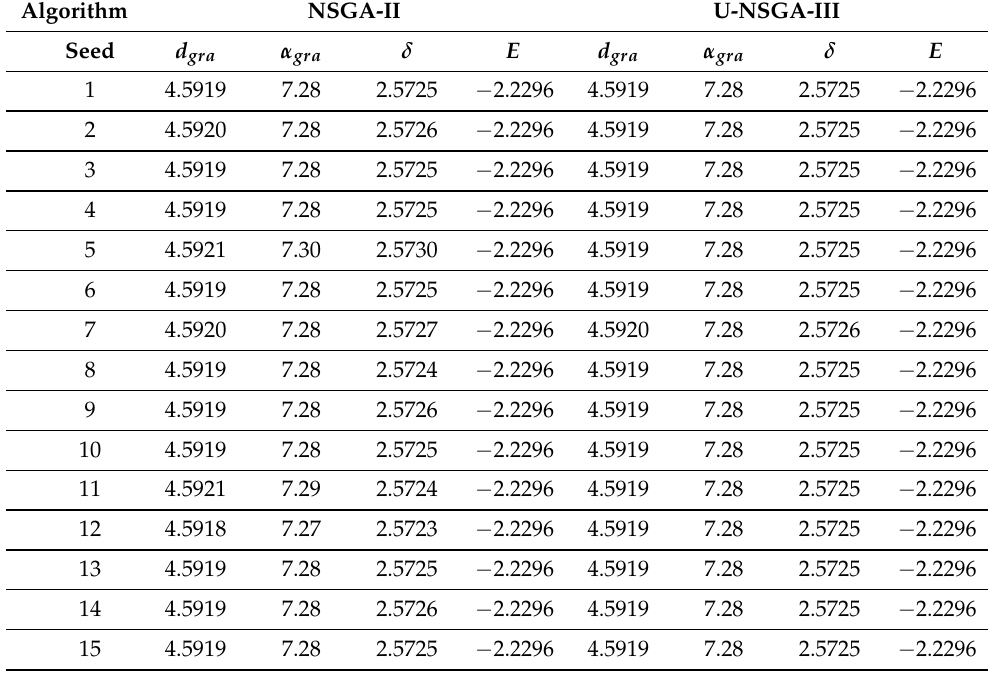
Table 4. Numerical results of d gra (Å), α gra (degrees), δ (Å) and E (eV) for the interaction between DOXH and graphene. They result in the same molecular